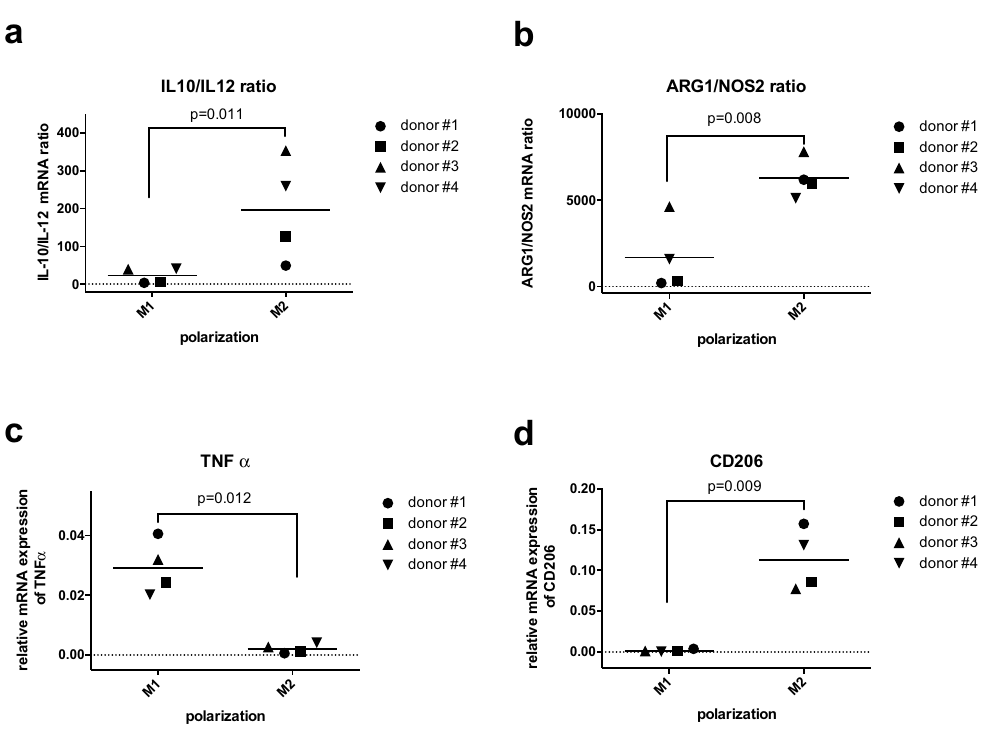
Figure 2. Gene expression profile evaluated by RT-qPCR. Scatter plots of IL-10/IL-12 mRNA ratio ( a ), ARG1/ NOS2 mRNA ratio ( b ), TNF- α relative mRNA expression ( c ) and CD206 relative mRNA expression ( d ) are